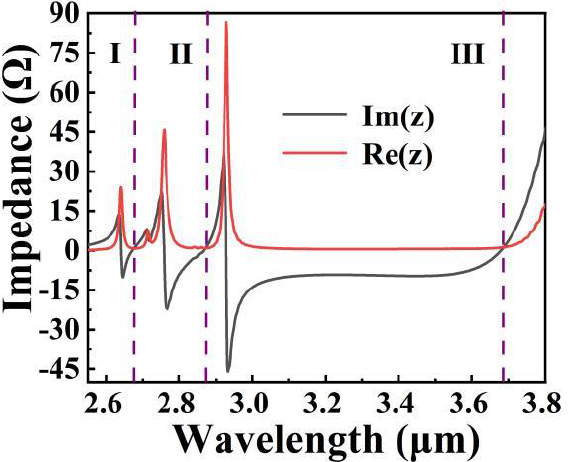
Figure 2. The matching diagram of absorber impedance changing with wavelength when other parameters are fixed. The black line represents the imaginary part Im(z) of the impedance, and the red line represents the real part Re(z) of the impedance. When Im(z) and Re(z) are matched (Im(z) = 0, Re(z) = 1), the wavelengths corresponding to the optimal impedance values of modes I, II, and III are located at the dotted line.